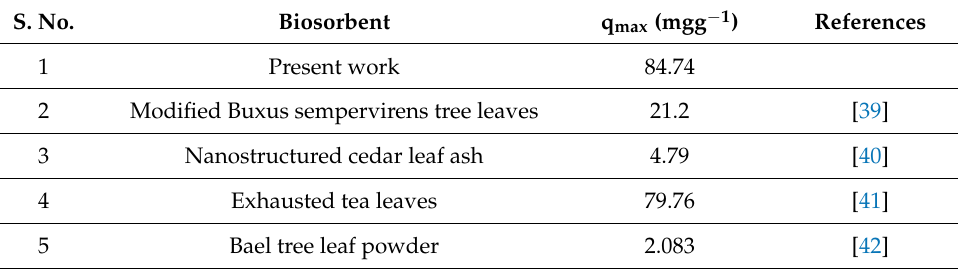
Table 5. Adsorption capacity of present adsorbent compared with those reported in